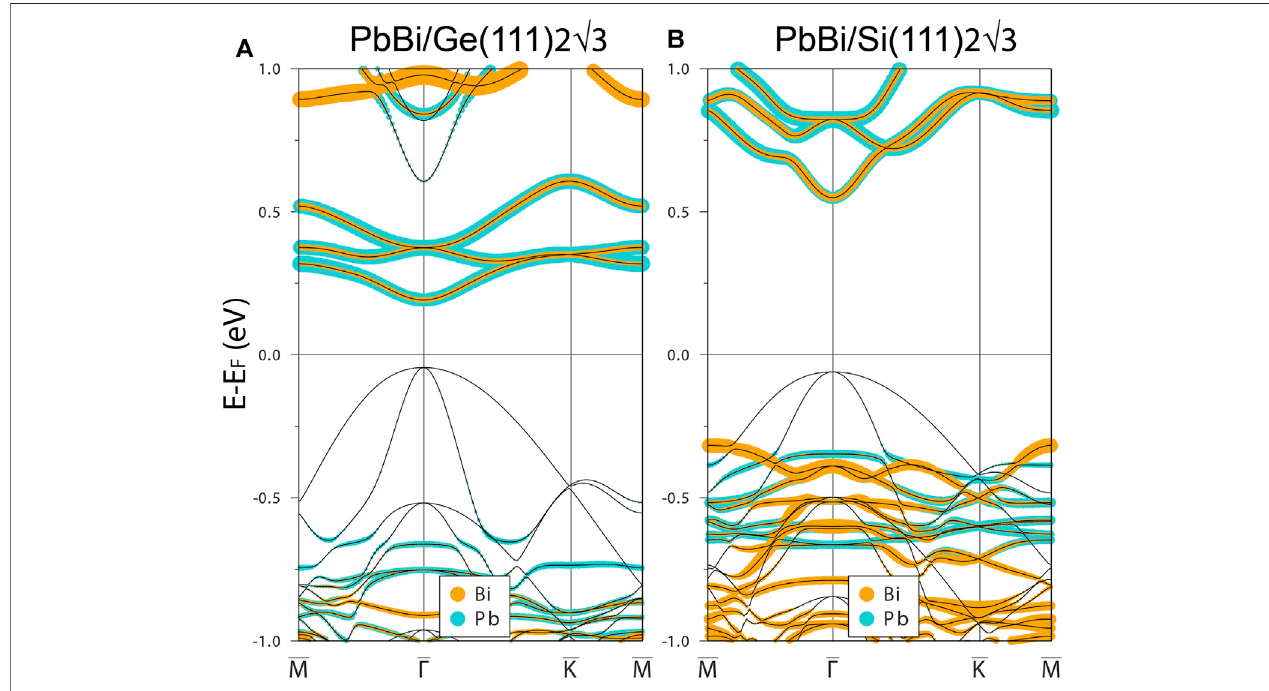
(cid:1)(cid:1) √ FIGURE 3 | The electronic band structure of 2 3 -PbBi phase adsorbed on (A) germanium, and (B) silicon substrates. Both fi gures present elements-projected non-relativistic spectra, where the elemental characters of the bands are shown by colored circles, blue and orange for Pb and Bi orbitals, respectively.